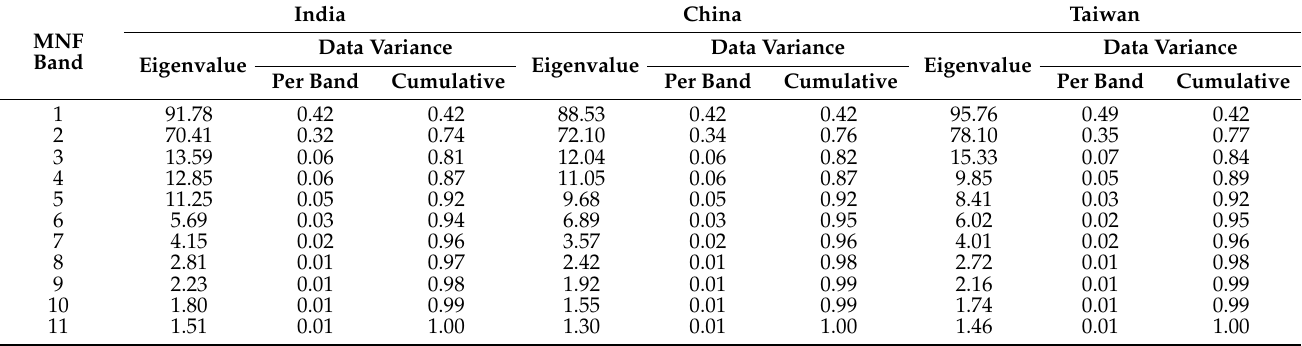
Table 3. Statistics of MNF